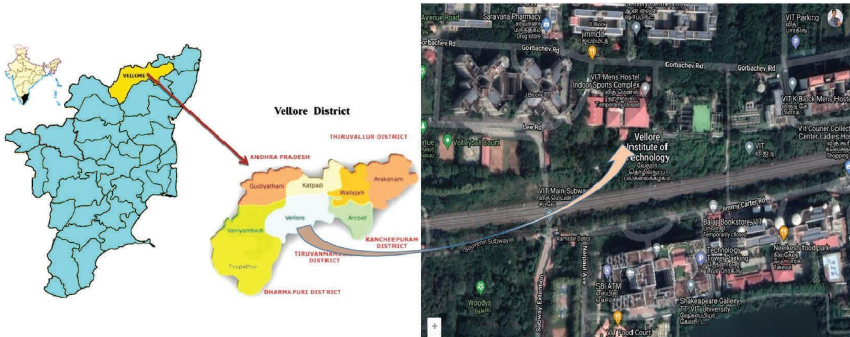
Figure 2: Site map of VIT,